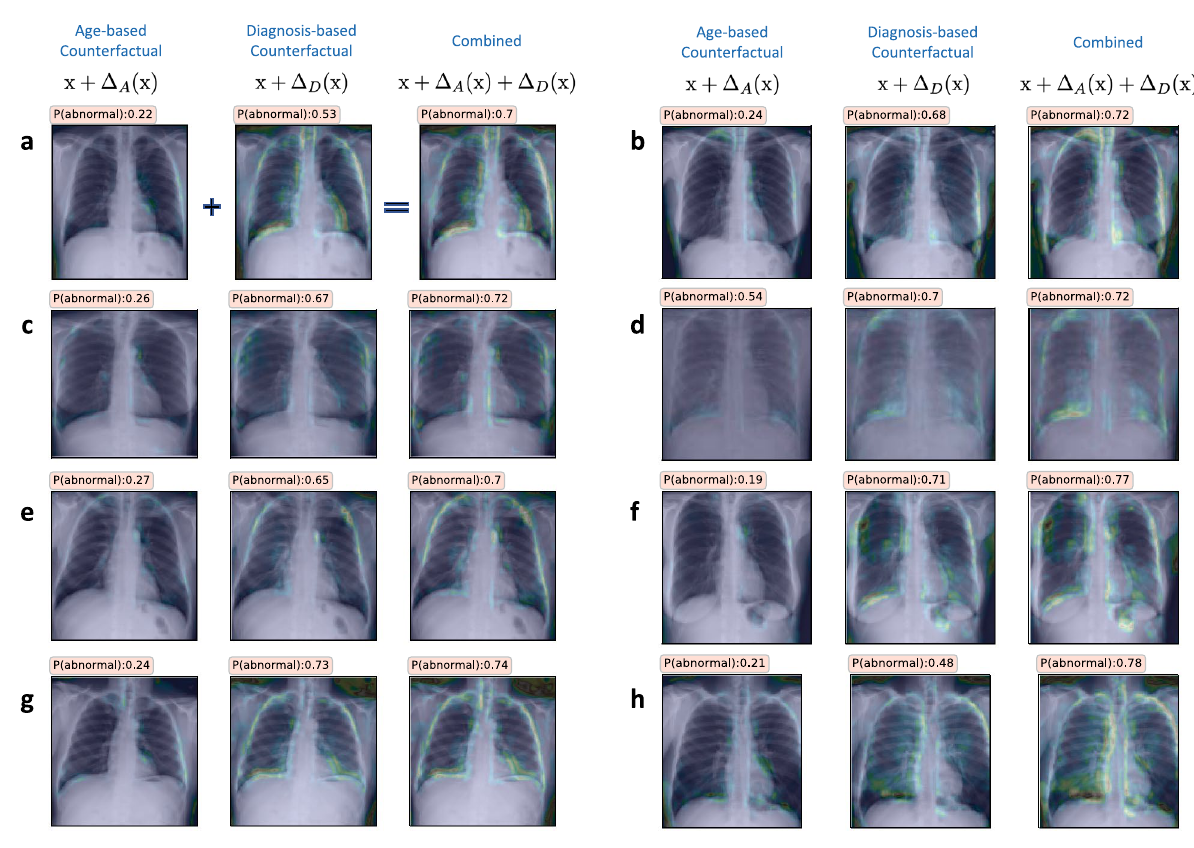
Figure 5. ( a – h ) Explanations generated using TraCE by introducing age-specific attributes into the counterfactuals synthesized for changing the diagnosis state of a normal subject to be abnormal . Interestingly, we find that there exists a correlation between the two attributes, as evidenced by the consistent increase in the likelihood P ( state = abnormal ) when compared to counterfactuals that rely only on patterns from the diagnosis state predictor. In each case, we highlight the changes � A ( x ) , � D ( x ) , (� A ( x ) + � D ( x )) and display the likelihood P ( state = abnormal )